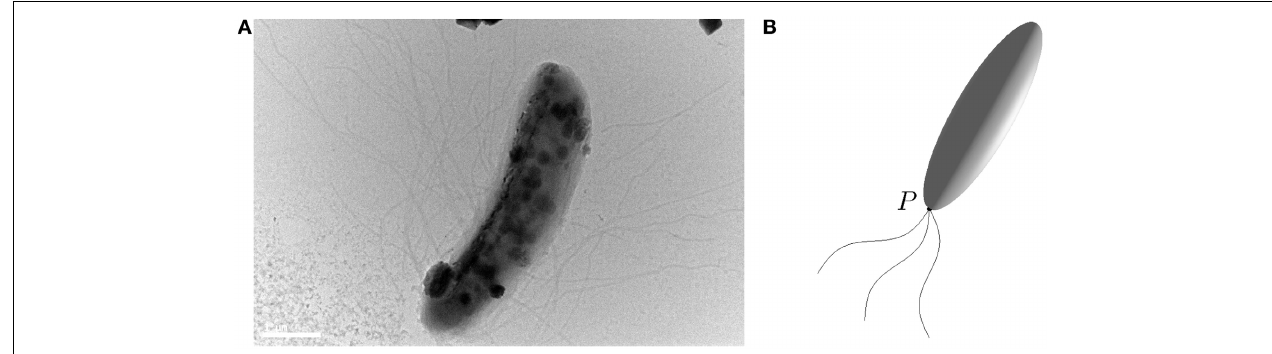
approximation of the rod-shaped bacterium for which its swimming motion is powered by the rapid rotation of helical flagellar filaments at a fixed point P